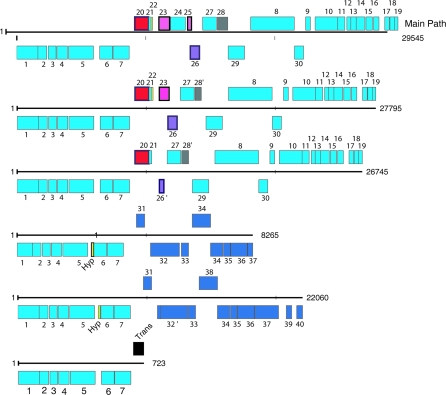
A High-Frequency Variant Region with Six Alternate Paths, One of Which Contains a Complete LuxIR PathwayThe main genome path is shown on the top line with alternative paths below. Light blue indicates genes present on the main genome path, dark blue indicates genes shared between two of the variants, yellow indicates hypothetical proteins, black indicates transposases, red indicates phage integrases, and pink (top strand) and purple (bottom strand) indicate genes potentially involved in the LuxIR pathway. Hypothetical proteins in the LuxIR region are shown in grey. Genes are annotated as follows: (1) l-aspartate oxidase; (2) probable ferredoxin; (3) conserved hypothetical protein; (4) citrate synthase; (5) aconitate hydratase (same as aconitase); (6) succinyl-CoA synthetase, alpha subunit; (7) succinyl-CoA synthetase, beta subunit; (8) pyoverdine chromophore precursor synthetase; (9) hypothetical protein; (10) acetolactate synthase, large subunit; (11) acetolactate synthase, small subunit; (12) hypothetical protein; (13) conserved hypothetical protein; (14) biotin synthesis; (15) DNA binding protein; (16) hypothetical protein; (17) protein of unknown function; (18) hypothetical protein; (19) acetylornithine aminotransferase; (20) phage integrase; (21–22) hypothetical protein; (23) Lux R; (24) transposase; (25) Lux R; (26) Lux I; (26′) short Lux I; (27) cytochrome P450 family protein; (28) hypothetical protein; (28′) truncated hypothetical protein; (29) transposase; (30) transposase; (31) hypothetical protein; (32) diguanylate cyclase; (32′) diguanylate cyclase frame shifted; (33) putative protein tyrosine phosphatase; (34) UDP-glucose 4-epimerase; (35) hypothetical protein; (36) UDP 6-dehydrogenase; (37) glucosamine-fructose-6-phosphate aminotransferase; (38) putative sigma54-specific transcriptional regulator, Fis family; (39) hypothetical protein; and (40) putative sigma54-specific transcriptional regulator, Fis family.